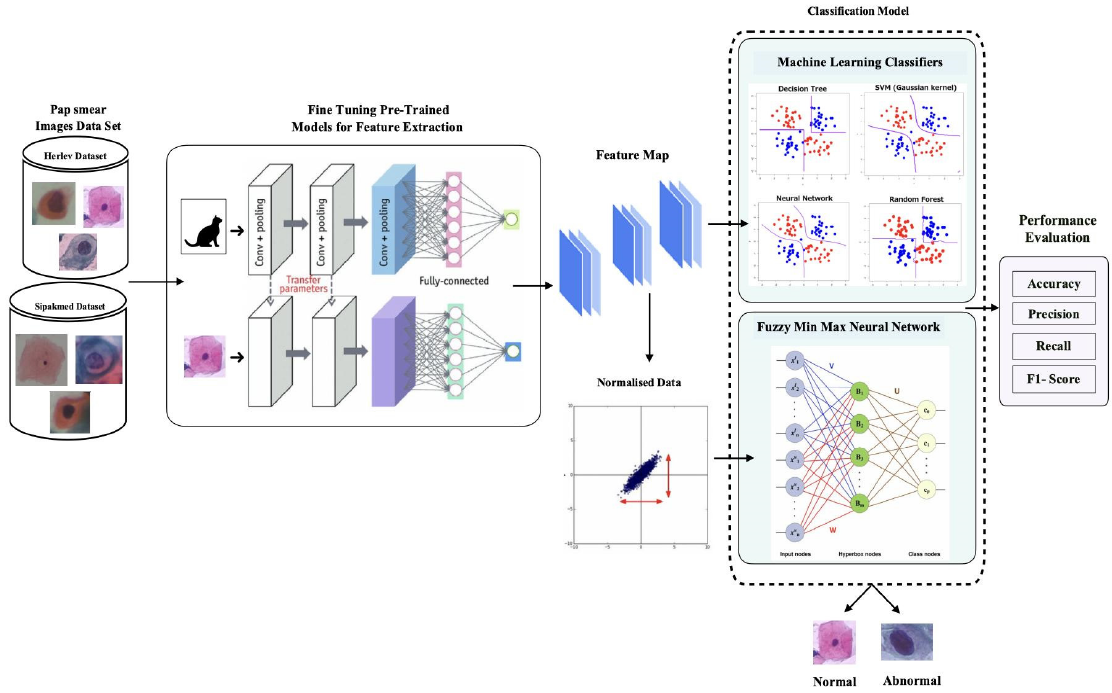
Figure 2. Block diagram of proposed